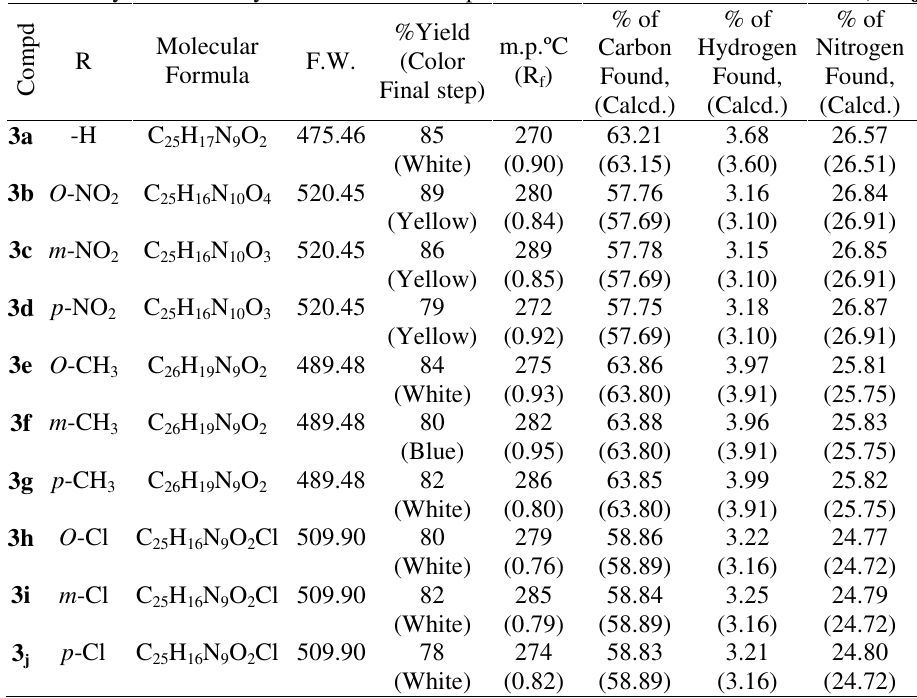
Table 1 . Physical and analytical data of title compound and its other substitute derivatives